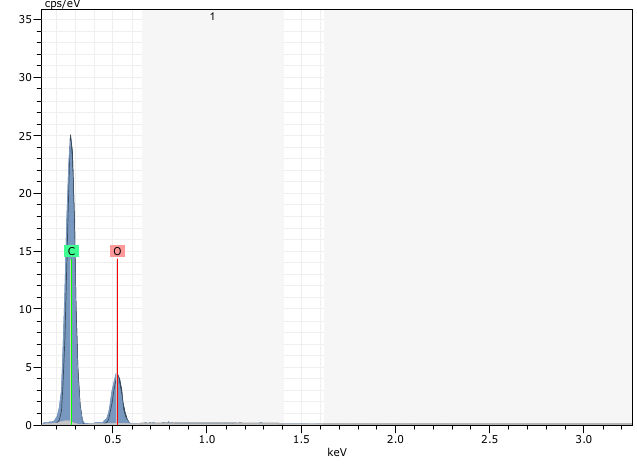
Figure 4. Energy dispersive X-ray (EDX) spectrum of the prepared M-PMs.